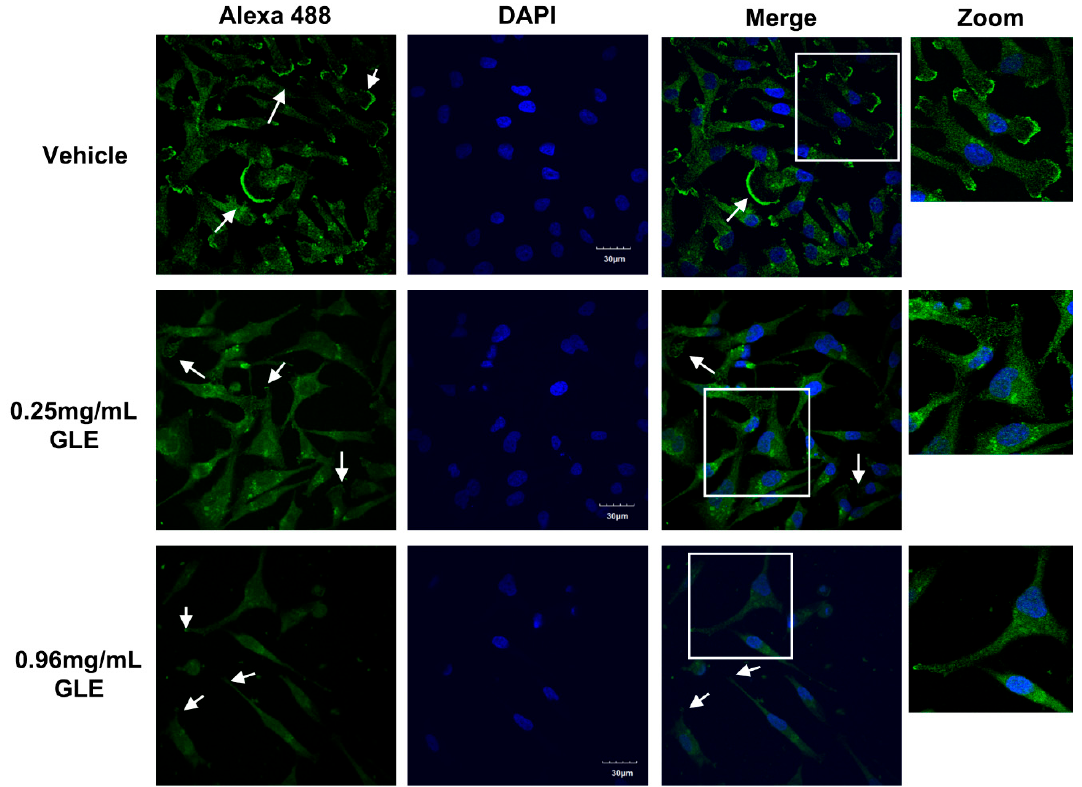
Figure 5. GLE inhibits Lpd expression in MDA-MB-231 breast cancer cells. MDA-MB-231 (1.4 × 10 4 ) cells were grown in 5% FBS media for 24 h prior to treatment with vehicle or GLE (0.25 mg/mL, 0.96 mg/mL) for 24 h. Cells were fixed and stained with DAPI (blue) and anti-Lamellipodin (green) per manufacturer’s instructions. White arrows show lamellipodia. Experiments represent data obtained from three independent biological replicates. Zoom in each image is shown in white squares, and each share equal dimensions. Scale bars = 30 μ m.